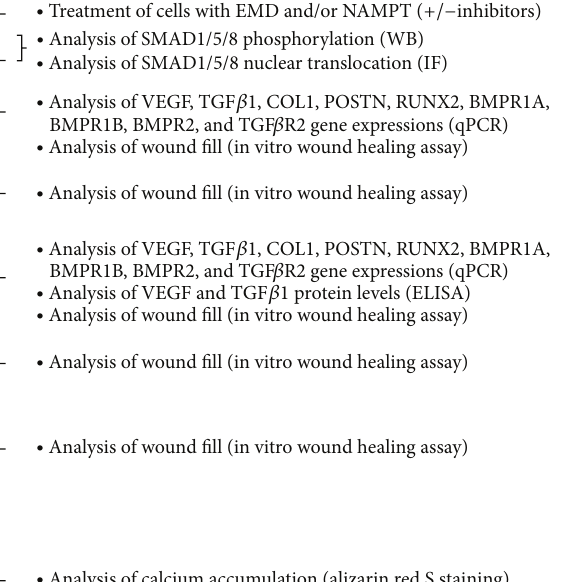
a template in a 25 𝜇 L reaction mixture containing 12.5 𝜇 L 2x QuantiFast SYBR Green PCR Master Mix (Qiagen), 2.5 𝜇 L